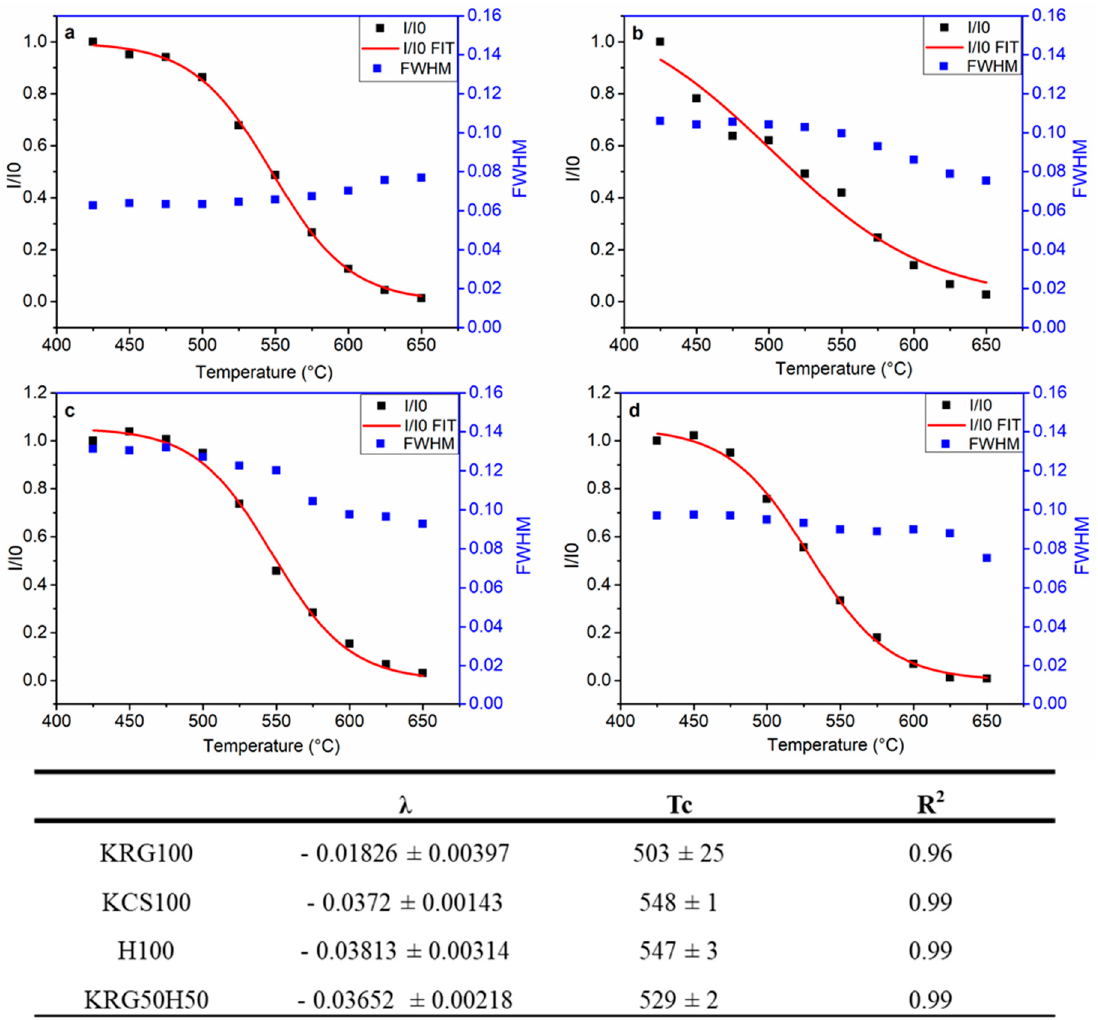
Figure 8. The variation of the intensity and FWHW of (002) peak, versus the temperature for ( a ) KCS100, ( b ) KRG100, ( c ) H100, ( d )KRG50H50, and ( e ) FIT parameters. ( b ) KRG100, ( c ) H100, ( d ) KRG50H50, and ( e ) FIT